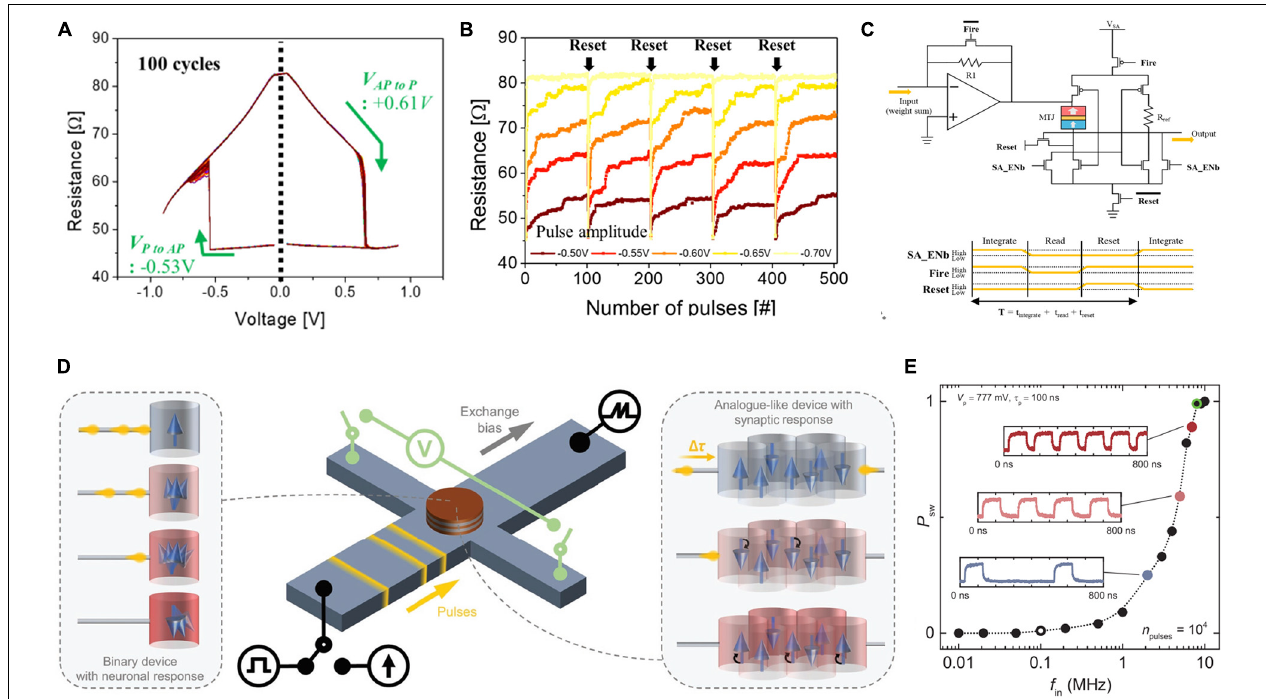
FIGURE 8 | (A) Resistance vs. voltage curve in the STT–MTJ device. (B) Repeated integration characteristic of the STT–MTJ. (C) Neuron circuit and integrate-and-fire behavior (Kim D. W. et al., 2020). (D) Functioning of the artificial neuron and synapse based on antiferromagnetic SOT–MTJ. (E) Dependence of switching probability on the frequency of incoming pulse trains (Kurenkov et al.,